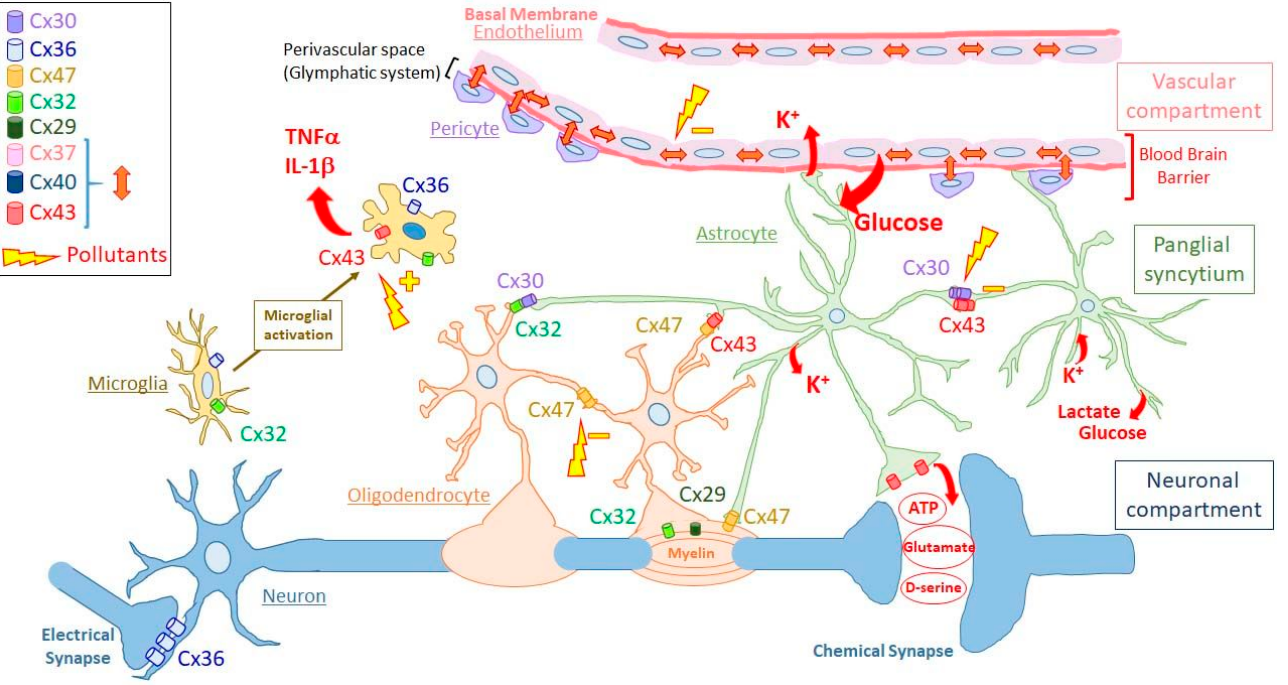
Figure 2. Schematic representation of the organization and connexin composition of the gap-junction compartments in the human adult brain. The different gap-junction compartments are indicated on the right side of the figure (vascular compartment, panglial syncytium, neuronal compartment). Principal cell types are presented for each gap-junction compartment (vascular compartment: endothelial cells or endothelium with pericytes; panglial syncytium: astrocytes in green and oligodendrocytes with myelin surrounding axons of neurons; neuronal compartment: neurons connected by chemical or electrical synapses). For clarity, pericytes are not enveloped by basement membrane. Microglia are located apart since they do not seem to establish permanent gap junctions between microglial cells or with cells of the different gap- junction compartments. Microglial cells are presented in non-activated and activated states through microglial activation. The connexin isoforms expressed in the different cell types are indicated according to the code color inserted in the left side of the figure. For clarity, connexin hemichannels and gap junctions are both presented as cylinders. Cylinders present between cells are gap junctions made of the indicated connexins, while those located in nonintercellular areas are hemichannels. Cylinders inside myelin represent reflexive gap junctions between the concentrical layers of myelin around neuronal axons. The red double arrows in the vascular compartment represent gap junctions made of either Cx43, Cx37 or Cx40 between endothelial cells and between endothelial cells and pericytes. Single red arrows represent ions (K + ) and molecules passing through connexin channels, which are either gap junctions (transfer of K + and glucose uptaken from extracellular space to be released in blood or close to neurons, respectively) or hemichannels (release of pro-inflammatory cytokines like TNF- α and IL-1 β by activated microglia; ATP, D-serine or glutamate released by astrocytes). Yellow lightning bolts represents possible effects of pollutants as either, inhibitors ( − ) of gap-junctional intercellular communication or indirect activators (+) of connexin hemichannels (See Discussion part for details). For clarity, ependymocytes and stem cell niches are not shown and only two astrocytic endfeet are presented as constituents of the blood–brain barrier. At the level of the blood-brain barrier, the perivascular space delimited by the astrocytic endfeet is part of the so-called glymphatic system involved in draining interstitial fluid and removing metabolic